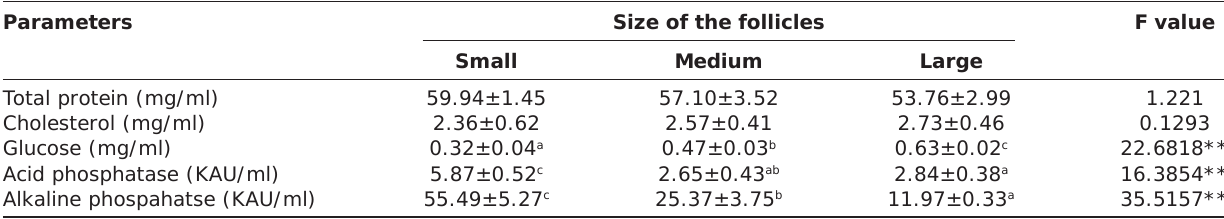
Table-1: Biochemical constituents and phosphatase activity (mean±SE) in fluid of different sized bovine follicles.